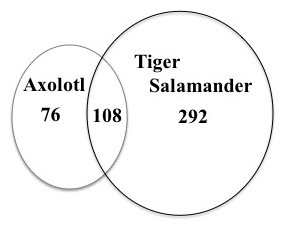
Venn diagram showing differentially expressed genes (DEGs). The figure shows DEGs identified uniquely from axolotls and tiger salamanders, and DEGs in common between the species.